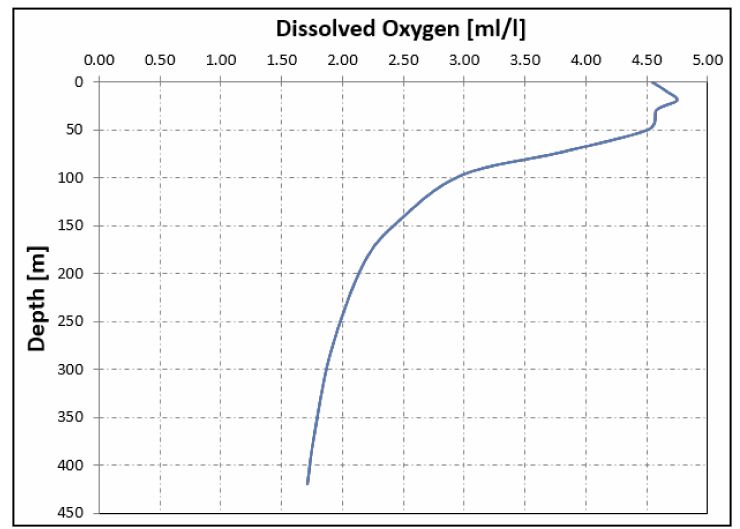
Figure 5. Deep seawater dissolved oxygen (mL/L) and depth profile of Pulau Kalumpang; data obtained from the online Japan Oceanographic Data Center